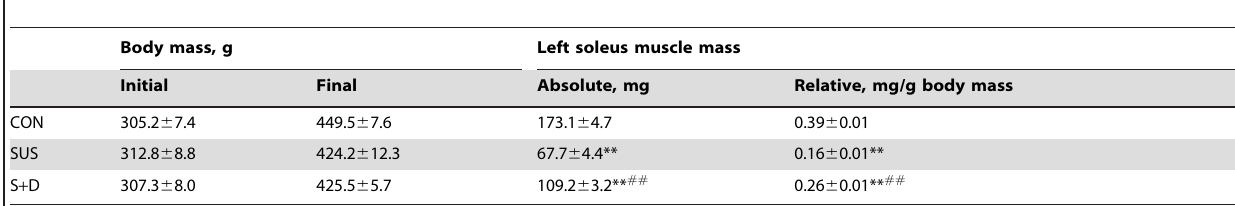
Table 1. Body mass and left soleus muscle (wet) mass of CON, SUS, and S + D rats in Protocol 1.